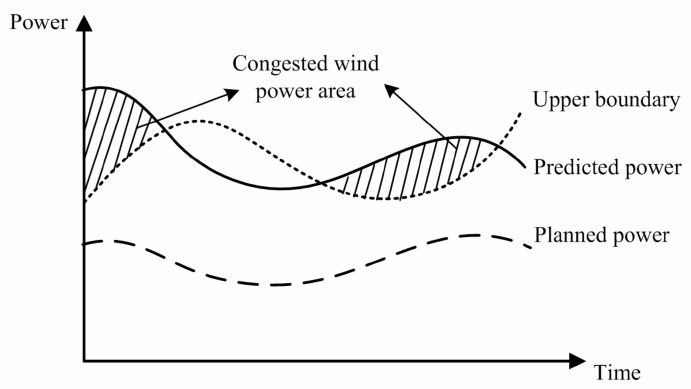
Figure 3. Schematic diagram of congested wind power